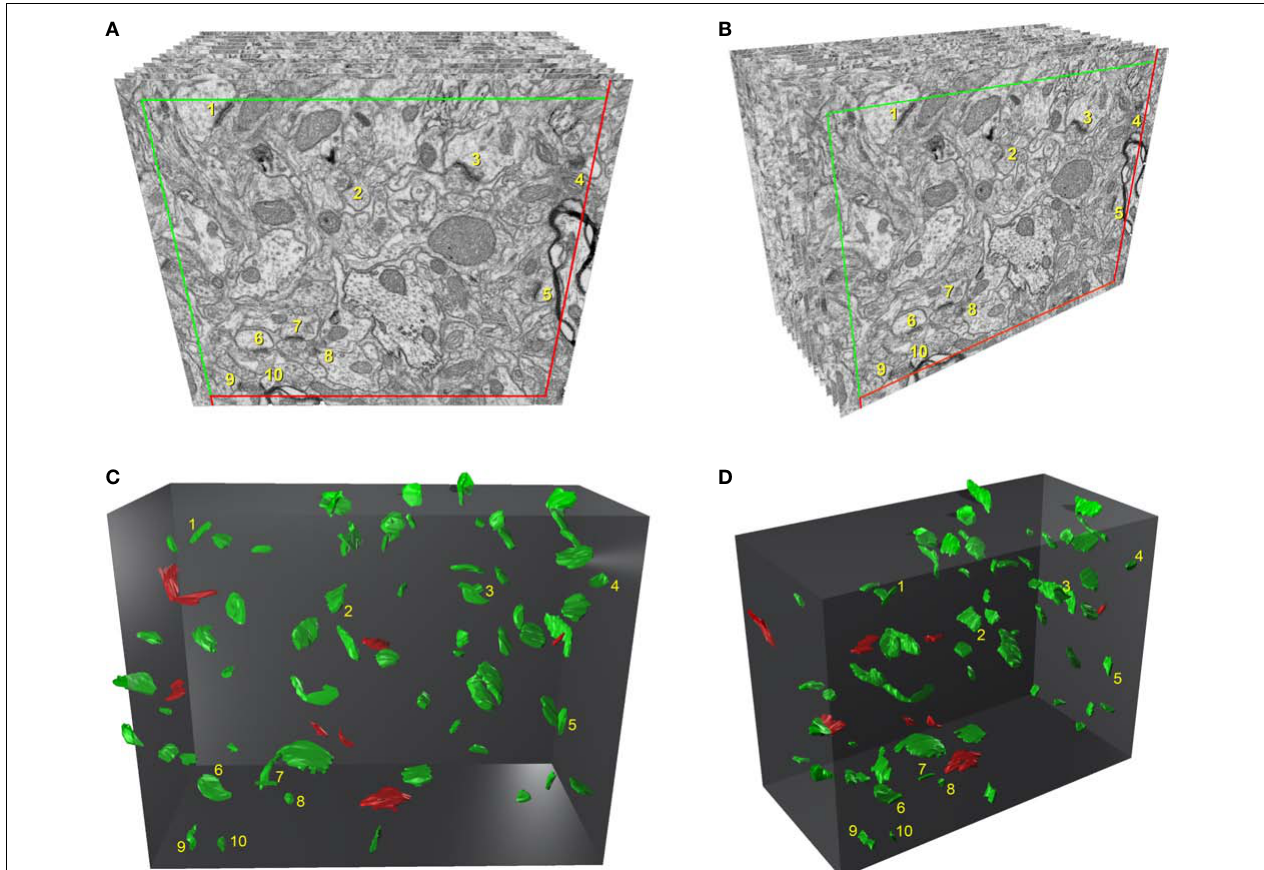
FIGURE 1 | Three-dimensional representation of a stack of serial sections and the synaptic profi les that appear in the corresponding counting brick. (A) and (B) show a stack of serial sections, slightly rotated counter-clockwise through the vertical axis in (B) . Only 12 sections are shown out of the 115 that compose the complete stack. An unbiased counting frame was drawn on each section, taking the green and the red lines as the acceptance and exclusion boundaries, respectively. To extend the counting frame to three dimensions, the front section was considered as an acceptance plane and the last section as an exclusion plane. Thus, synaptic profi les (contours of the synaptic membrane densities) were counted inside an unbiased counting brick bound by three acceptance planes (top, left and front) and three exclusion planes (right, bottom